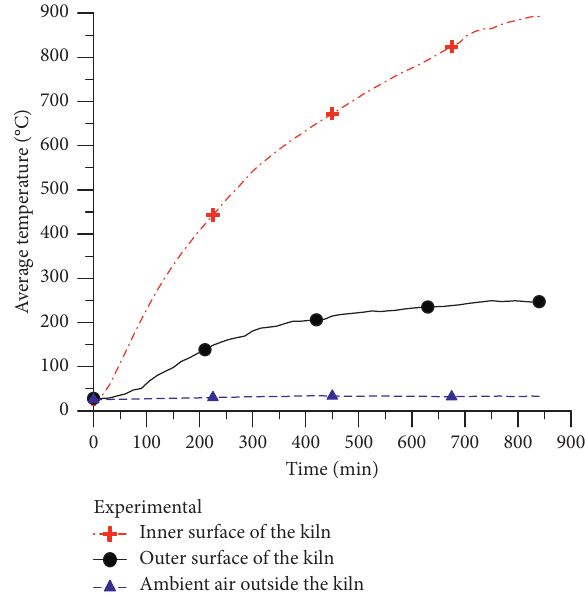
Figure 5: Average internal and external surface temperatures of the kiln wall, and ambient temperature as a function of time during the heating process. Table 3: Representative mesh size ( l ) as a function of thermal insulation thickness ( L insu